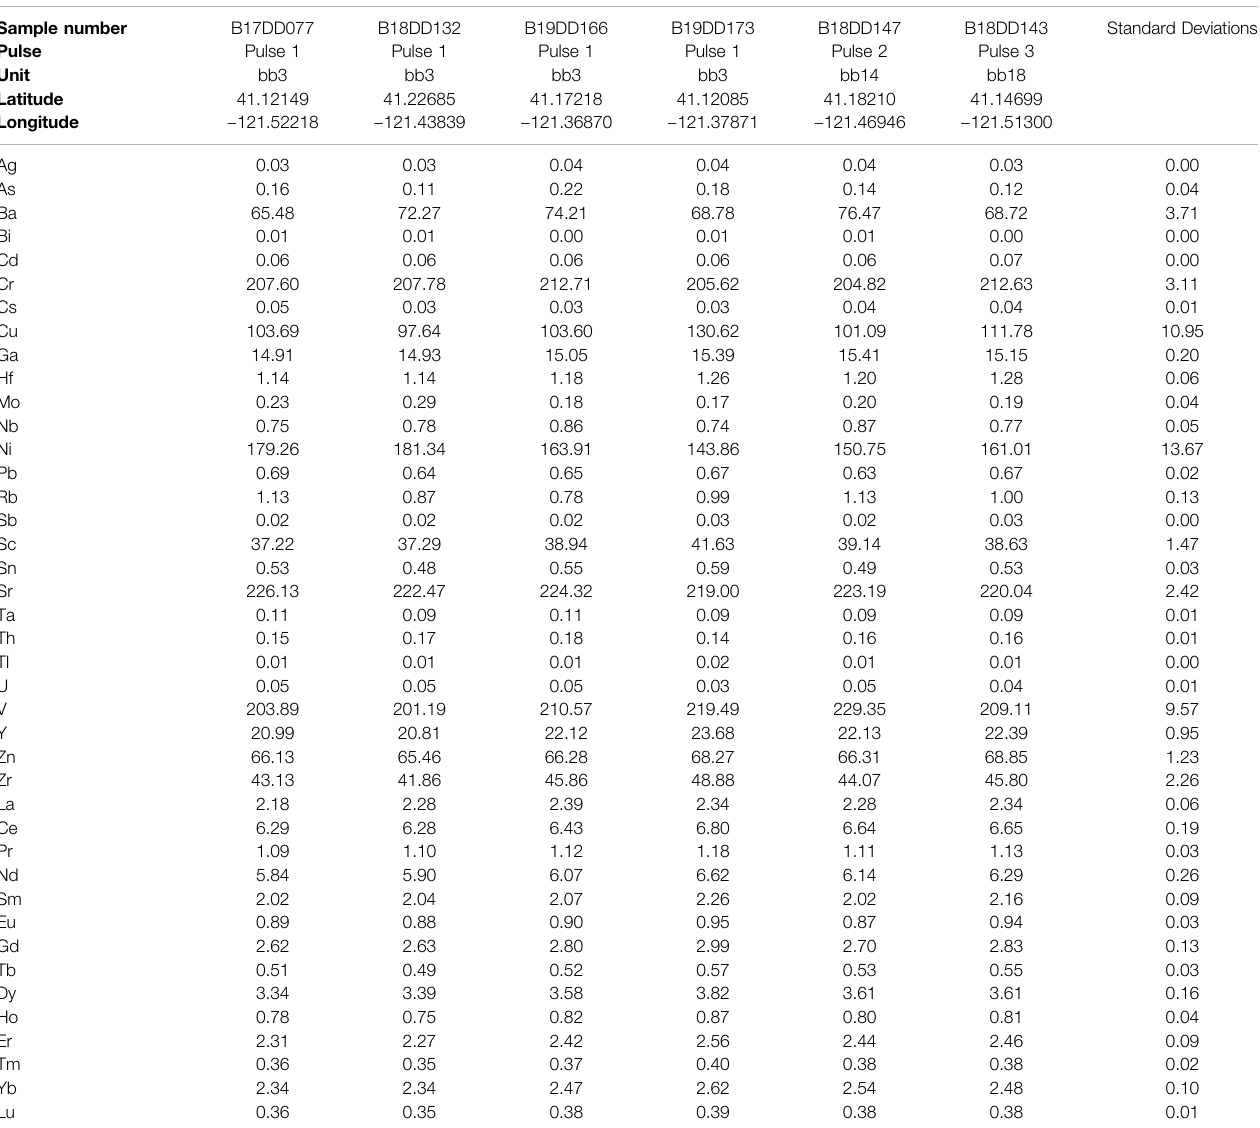
TABLE 1 | Trace-element geochemical analyses of the Brushy Butte fl ow fi eld. Sample